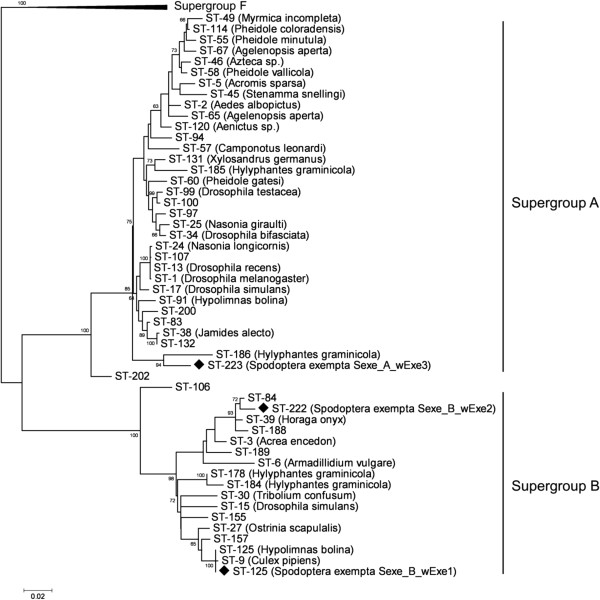
 Maximum-Likelihood (GTR+G+I model) phylogenetic tree for the concatenated MLST genes of Wolbachia isolates. The solid diamonds indicate the 3 strains isolated from S. exempta in this study. Where known, the names of the host species are given. The scale bar represents a 2% estimated difference in nucleotide sequence. Numbers given at each node correspond to the percentage bootstrap values (for 1000 repetitions). Replicate numbers of <60% were not included in the figure. Cimex lectularius Wolbachia ST-8 from Supergroup F is used as an outgroup.